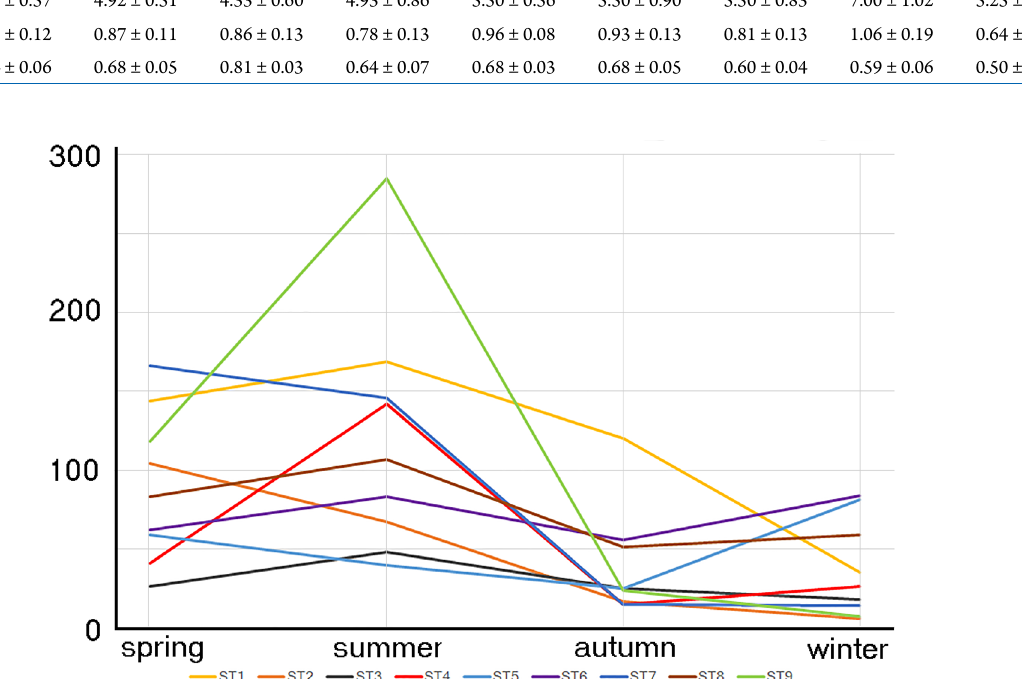
Figure 4. The seasonal variation in the mean abundance (ind./7.5 cm 2 ) of the harpacticoids at the